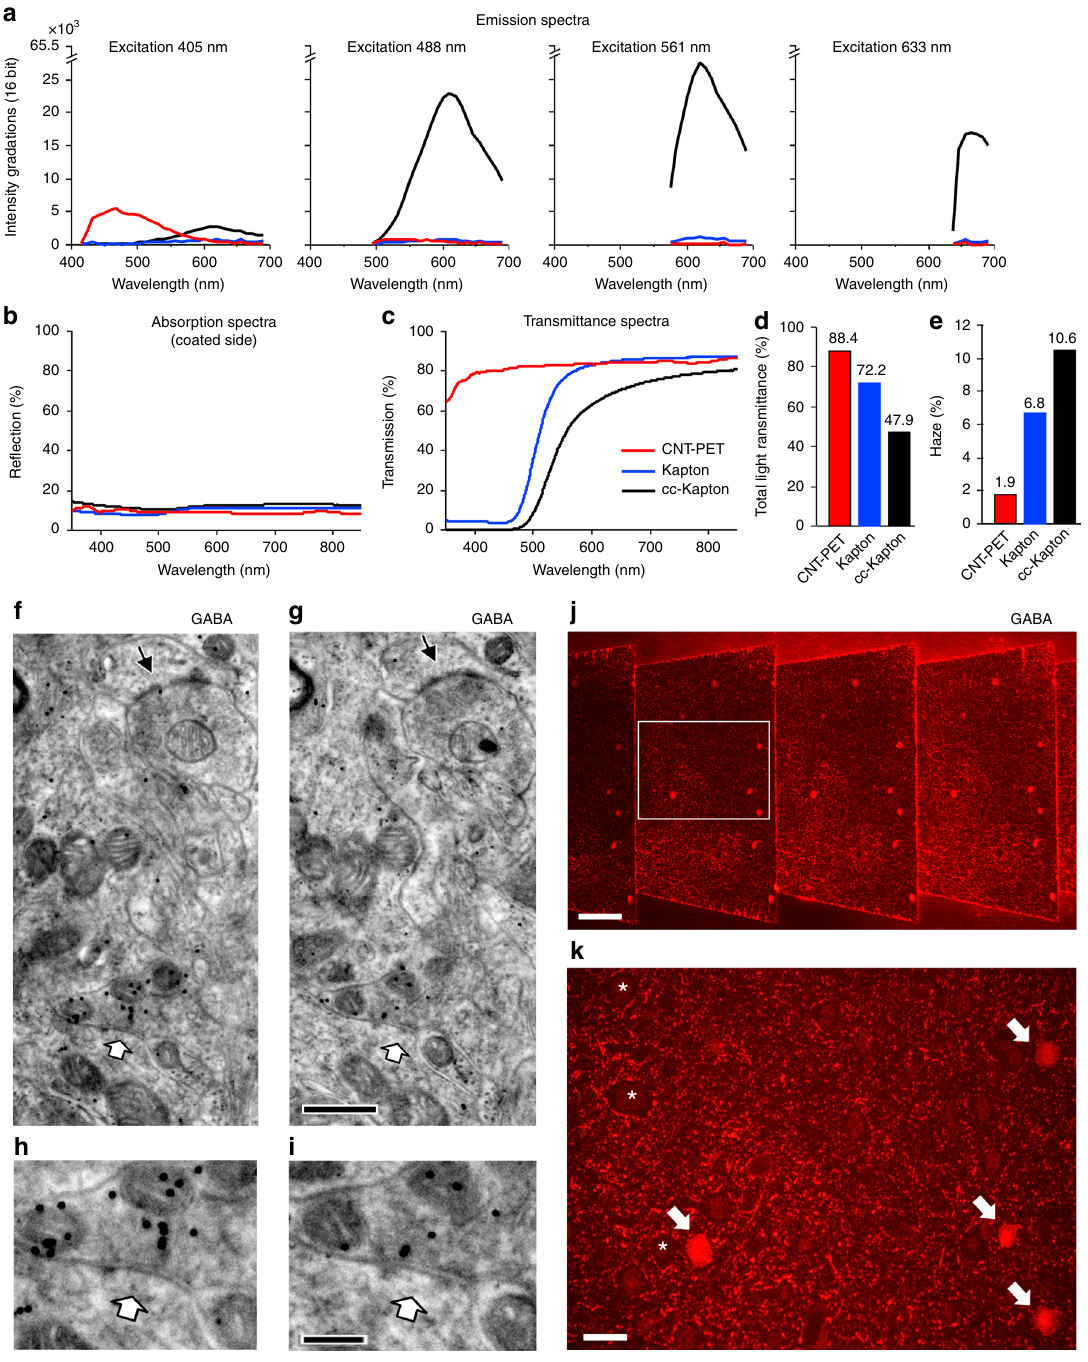
Fig. 4 CNT tape is feasible for light microscopy. a Emission spectrum, b Absorption spectrum, c Transmission spectrum, d Total light transmission, and e Haze of the CNT, uncoated Kapton and cc-Kapton tape. f , g GABA post-embedding immunoreaction with 15 nm colloidal gold particles on serial sections of rat striatum processed with TO on the CNT tape imaged with BSD at 5 keV, 3.2 µ s dwell time. GABAergic synapse (white arrow) and non-GABAergic synapse (arrow). Scale, 0.5 µ m. h , i Enlarged image of GABAergic synaptic contact indicated by a white arrow in f and g . Scale, 0.2 µ m. j GABA post- embedding immuno fl uorescent reaction on serial thin sections of rat cortex processed with TOLA on the CNT tape. Scale, 80 µ m. k Enlarged image of rectangle in j . GABA immunoreactive neurons (arrows) and basket like boutons (asterisks). Scale, 20 µ